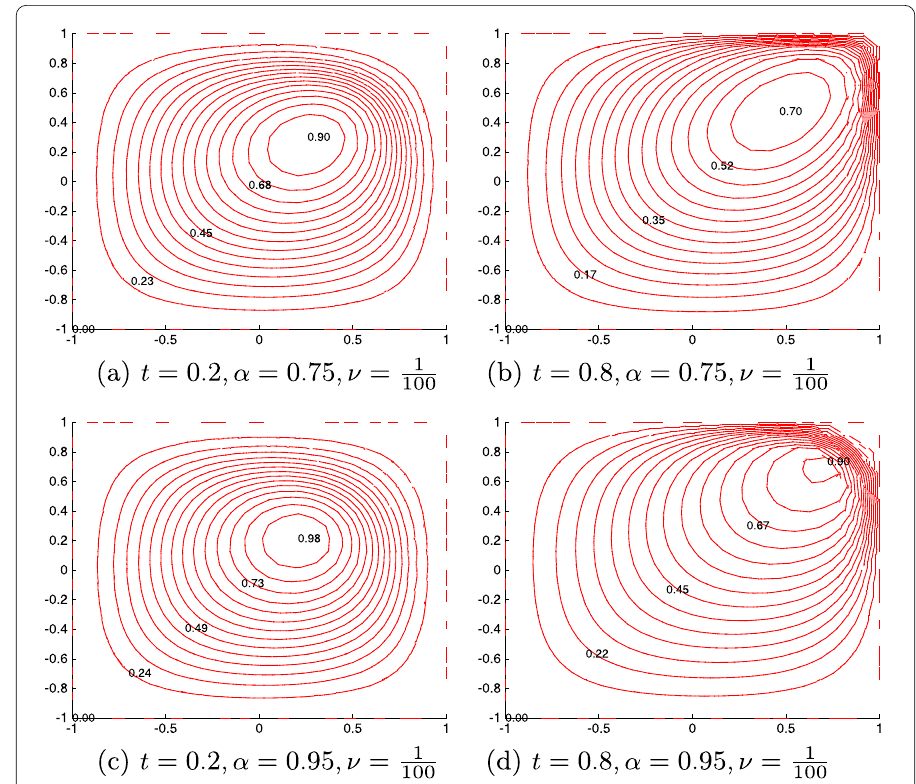
Figure 3 Solution of example 2 with different fractional orders and moderateReynoldsnumber (Re = 100) and at different times.